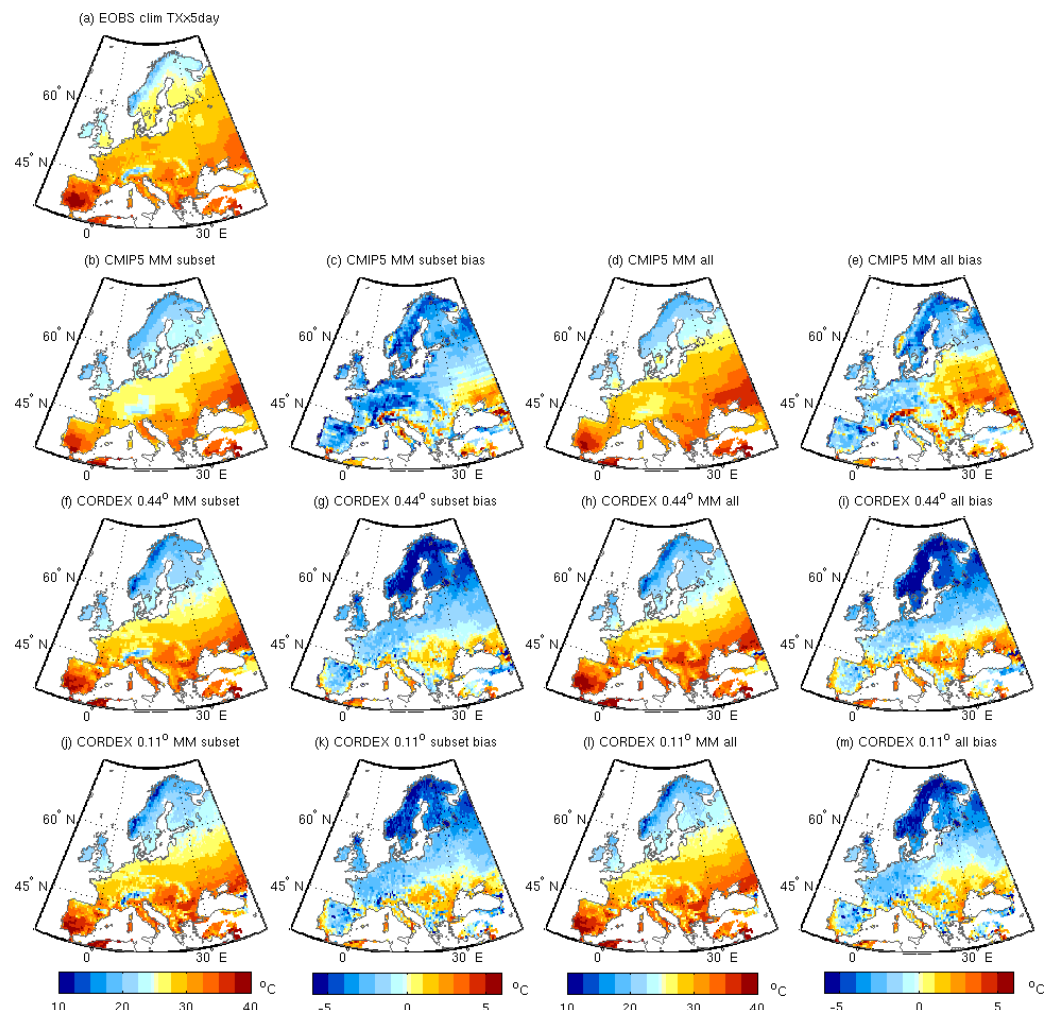
Figure 1. Climatological mean of TXx5day for the period 1970–2005 for (a) E-OBS; the multi-model median of the common subset of models (see Methods) for (b) CMIP5, (f) CORDEX 0.44 ◦ , and (j) CORDEX 0.11 ◦ , (c, g, k) their biases with respect to E-OBS, and (d, e, h, i, j, k) the same for the full ensembles of CMIP5 and CORDEX. Units: degrees